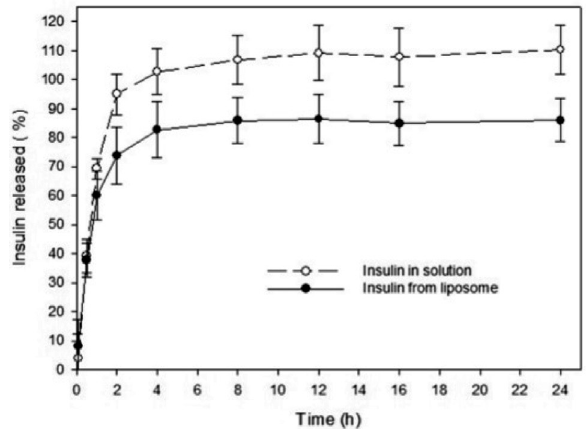
Figure 3. Release profiles of insulin in solution (open circles) and insulin from the liposome (solid circles). Each value express mean± standard deviation, n =